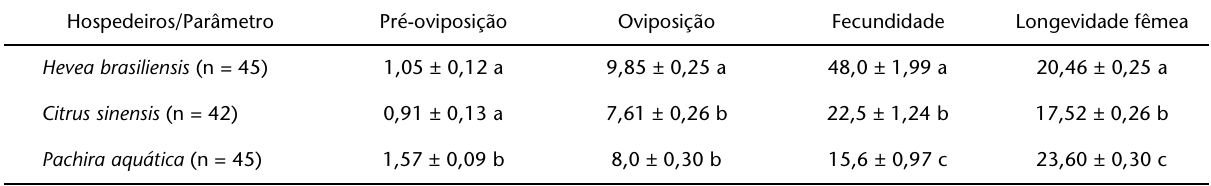
Tabela VI. Duração (dias) dos períodos de pré-oviposição, oviposição e longevidade das fêmeas de E . banksi sobre três hospedeiros. Fecundidade expressa em número de ovos por fêmea. BOD a 28 ± 1°C e 12 horas de fotofase; 70 ± 10% UR. Médias ± EP seguidas de